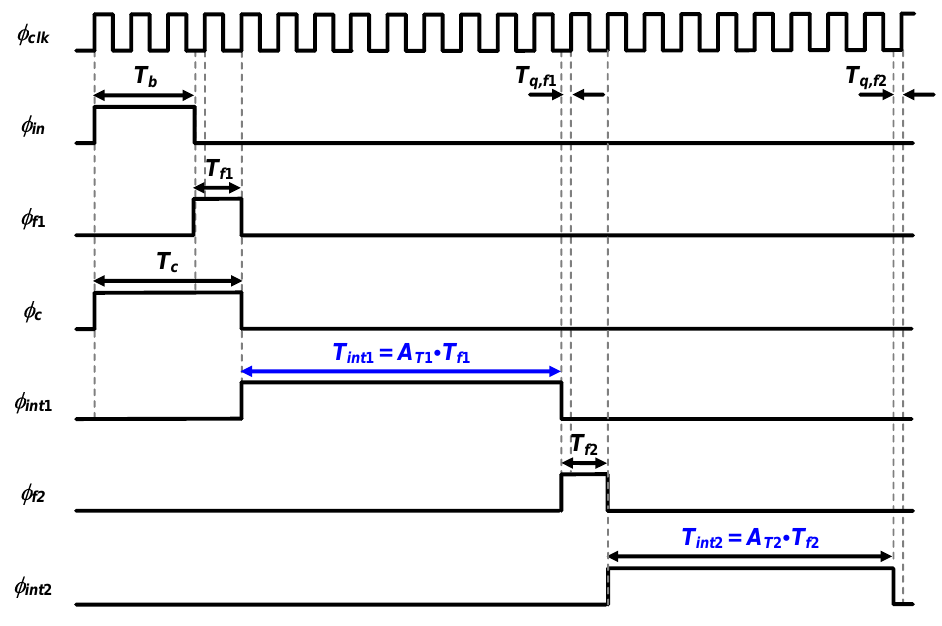
Figure 6. Timing diagram of the proposed TDC in mode C.